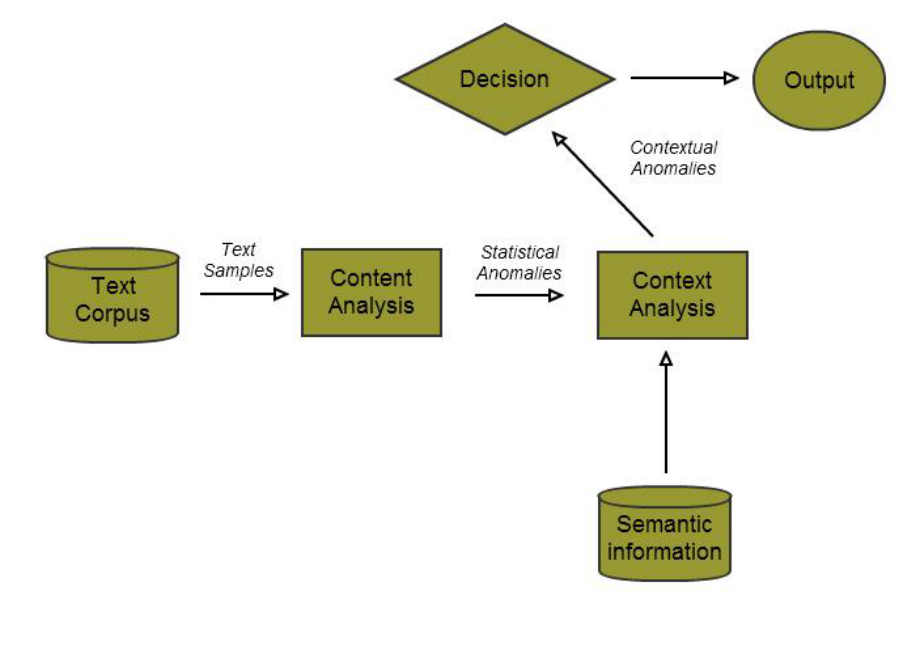
Figure 2. Flowchart of the decision